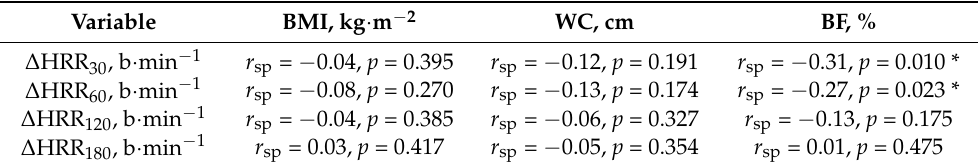
Table 3. Semi-partial correlations between body composition and HRR indices.